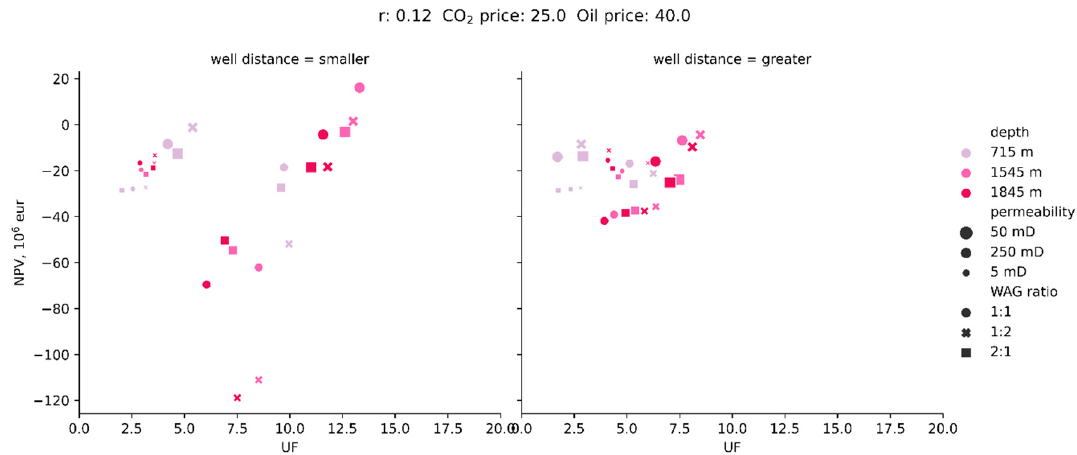
Figure 13. NPV versus UF for the realistic scenario at the end of EOR with 20 €/MWh electricity price.